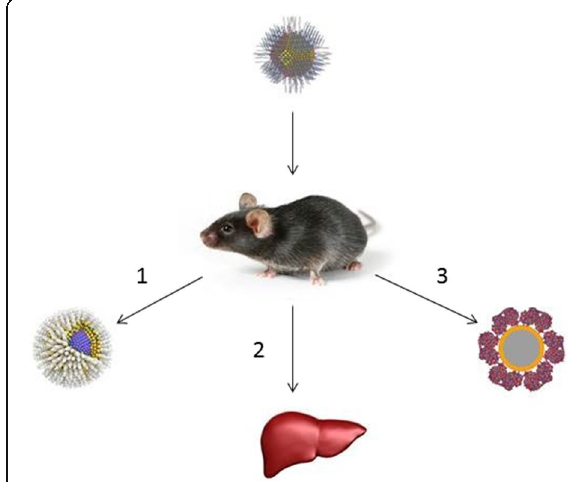
Fig. 2 The possible reasons why quantum dots may be nontoxic in animal models. (1) The shell prevents the leakage of heavy metals into the body [129, 135]. (2) Quantum dots are localized in the liver and subsequently eliminated from the body [135, 173]. (3) The protein crown around quantum dots protects the body from heavy metals [132,